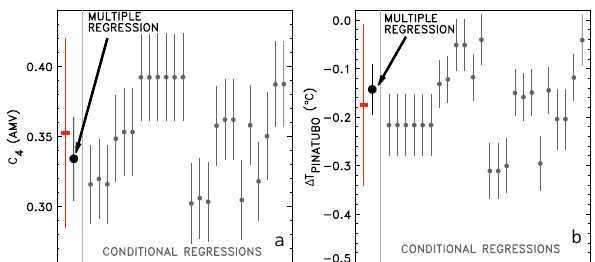
Fig. 8. Values of the AMV index regression coefficient (C 4 in Eq. (2)) (a) and maximum cooling due to the eruption of Mt. Pinatubo (absolute value of C 1 × 0.15) (b) calculated using the MLR model (large black circles) and from a series of conditional regressions (small gray circles; see text). Black and gray error bars denote the 95% confidence intervals (von Storch and Zwiers, 2002). The red horizontal bar denotes the mean of the 24 conditional re- gressions, and the red error bar denotes the 2 σ standard deviation about the mean. For each panel, the first six conditional regression points represent calculations for which C 1 was first computed. The second sextet show results for which C 4 was first computed. For the third sextet, C 3 was first computed and for the last, C 2 was first